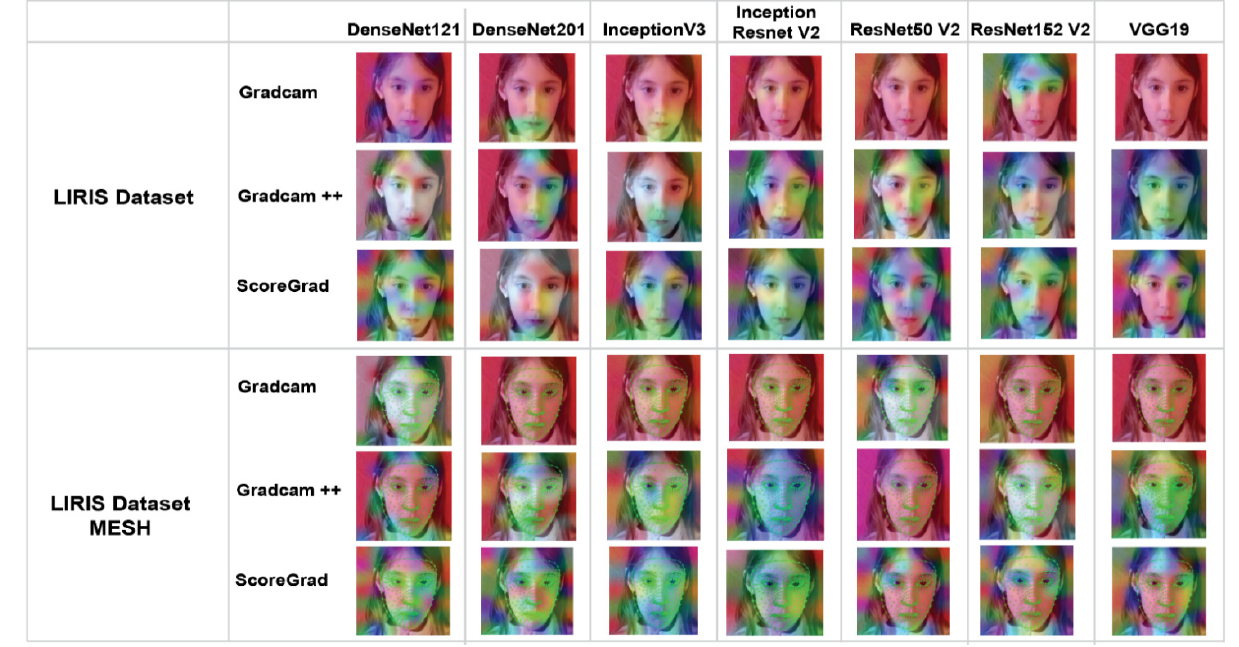
Figure 9. Saliency map of LIRIS dataset.